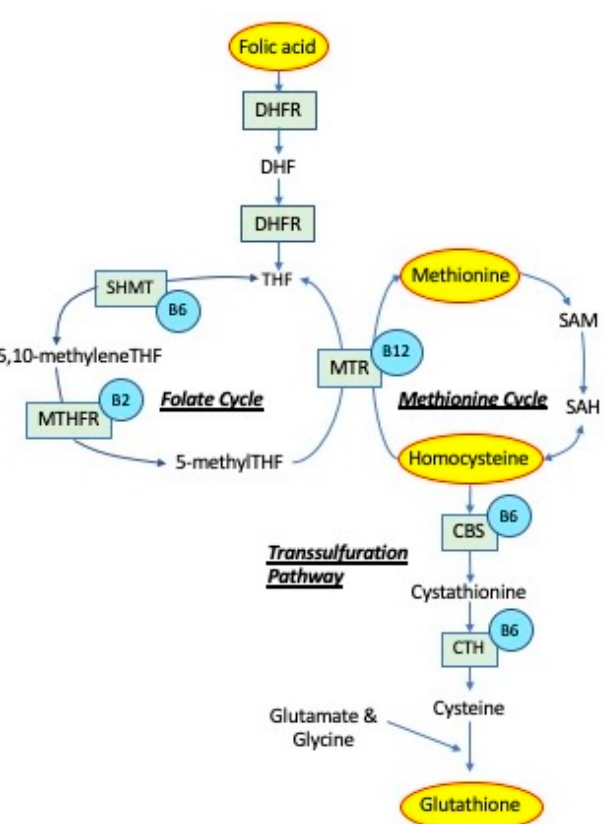
Figure 1. One-carbon metabolism. Folic acid obtained from the diet is reduced to dihydrofolate (DHF) and tetrahydrofolate (THF) by dihydrofolate reductase (DHFR). A methyl group is then transferred to THF by serine hydroxymethyltransferase (SHMT), forming 5,10-methyleneTHF. Vitamin B6 is